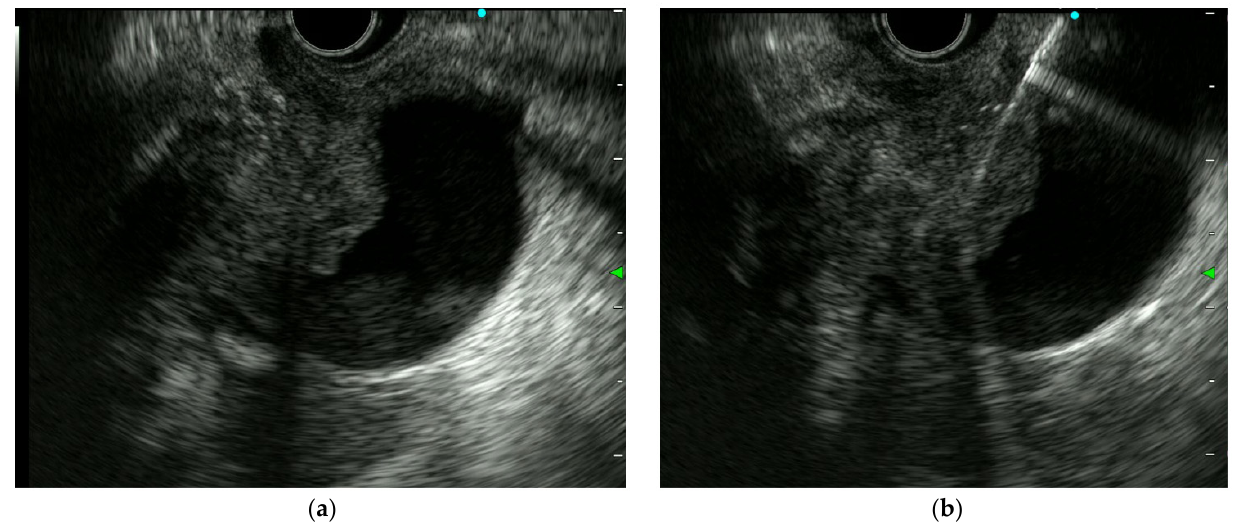
Figure 8. EUS-FNA of the gallbladder. ( a , b ) A case of gallbladder cancer: a thickened part of the gallbladder wall punctured while avoiding the gallbladder lumen.